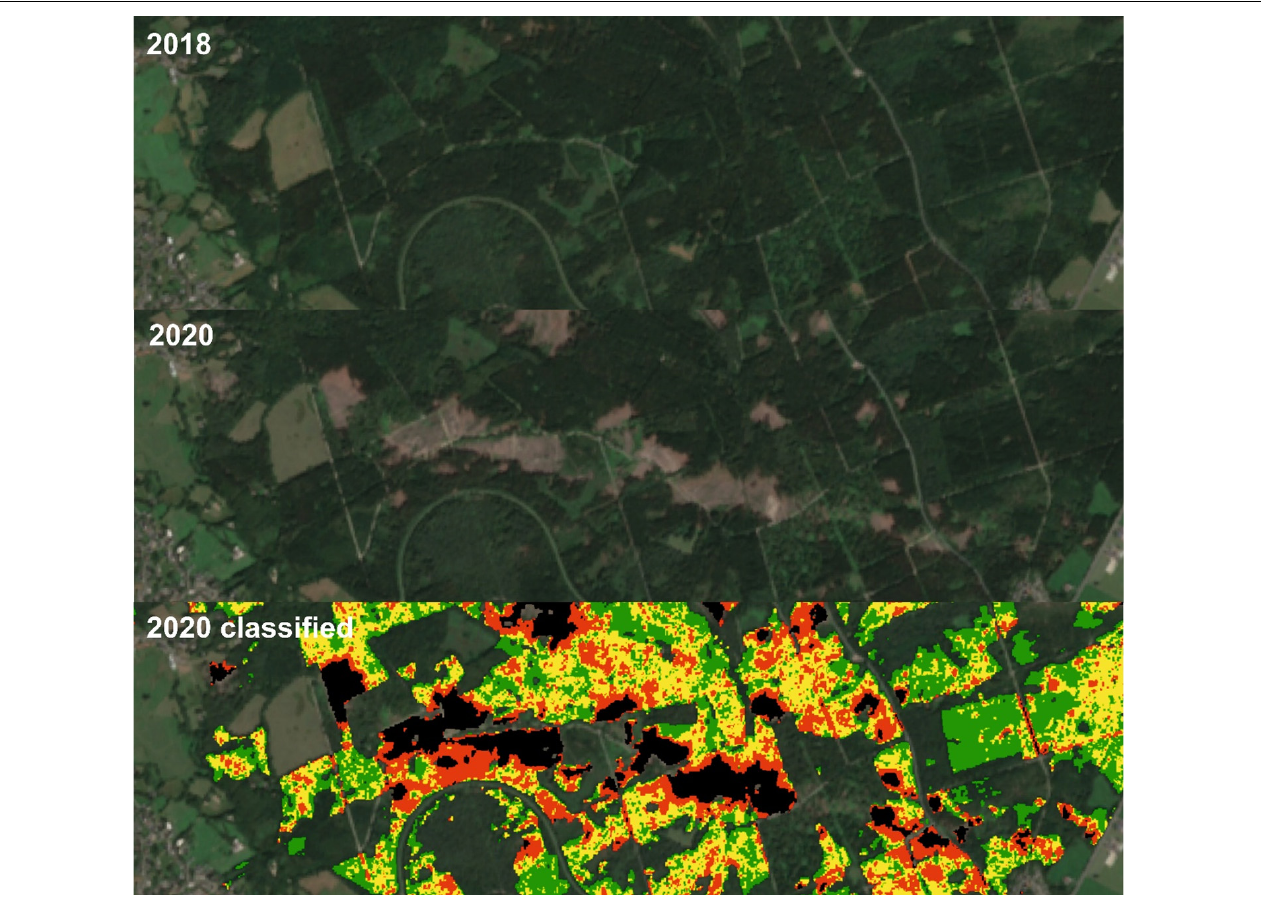
FIGURE 9 | Sentinel-2 median composite (RGB = B4, B3, and B2) for the year 2018 before the tornado (top), 2020 after the tornado (middle, CDF matched), and estimated spruce health classes in 2020 (bottom, removed = black, damaged = red, warning level = yellow, and healthy =